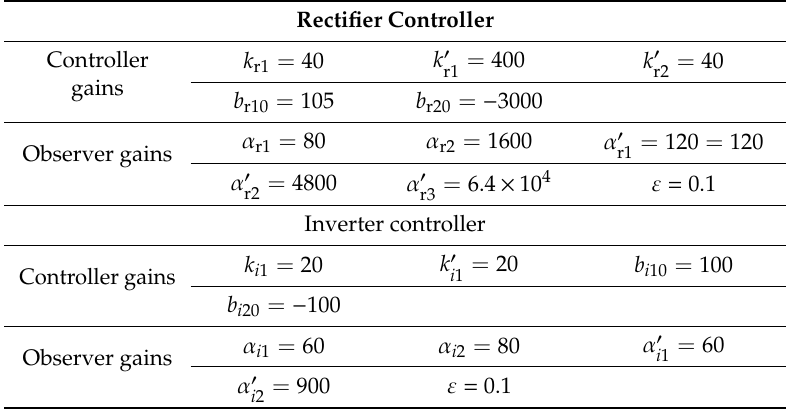
Table 4. Optimized controller gains and observer gains tuned by MSSA.